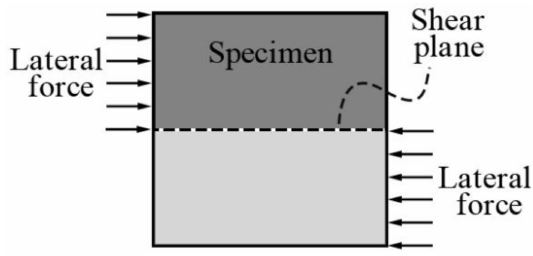
Figure 3. Direct shear loading diagrams.